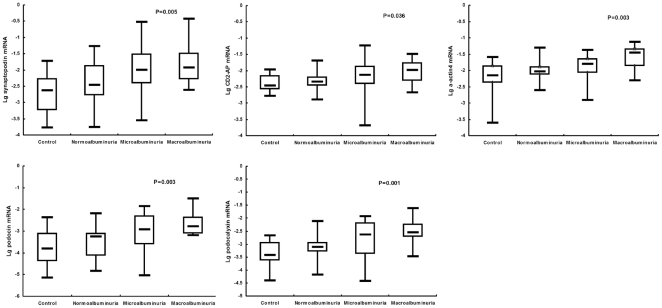
Comparison of podocyte-associated mRNA expressions in urinary in varying stages of DN and controls.Box plots show the the minimum value, 25th, 50th (median), 75th, and the maximum values for lg-transformed ratios of mRNA copies compared with β-actin mRNA copies for synaptopodin, CD2-AP, α-actin4, podocin and podocalyxin. mRNA expressions among overall four groups were compared using the Kruskal-Wallis test.